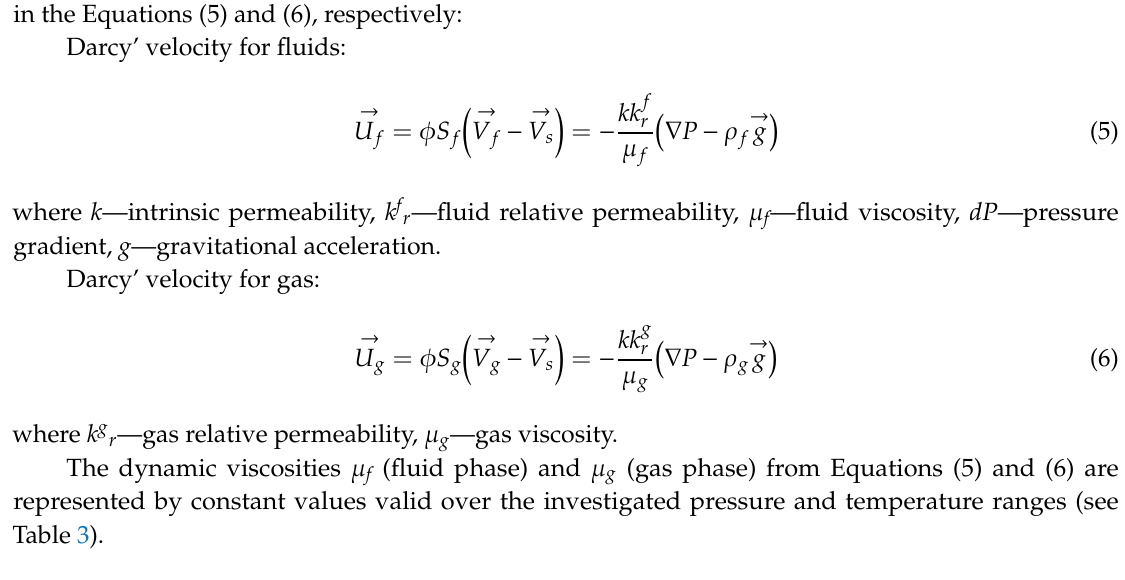
Table 3. Physical parameters used in numerical simulations (see further description in